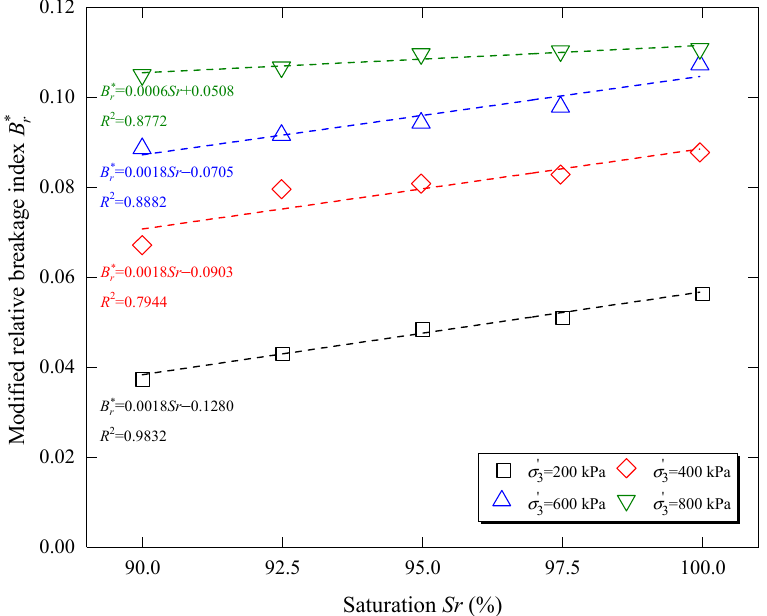
Figure 19. Relationship between modified relative breakage index and saturation of coral sand.